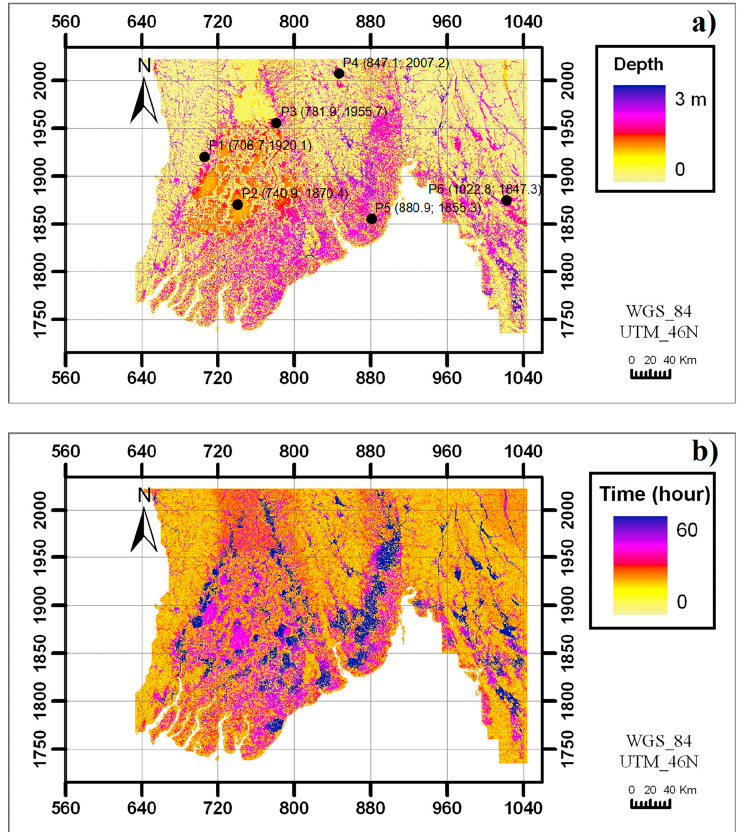
Figure 7. Flood depth images obtained for different simulation times.